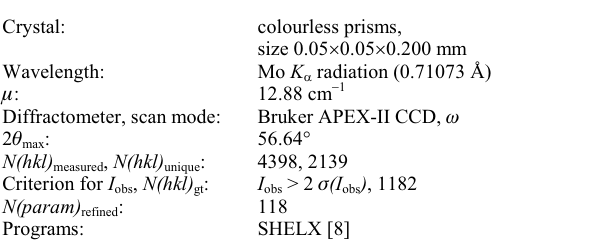
Table 1. Data collection and handling.